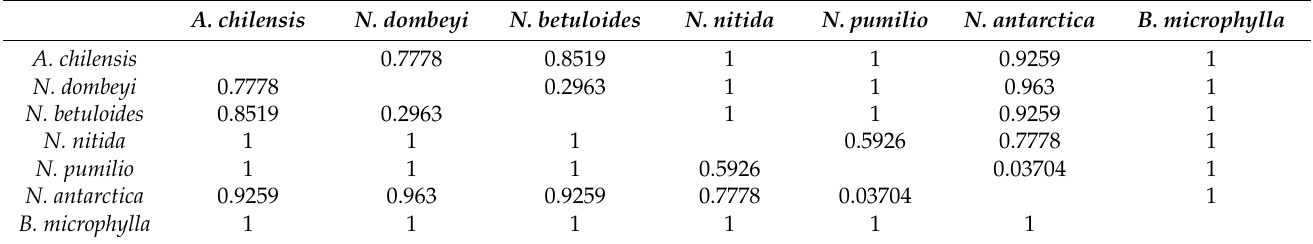
Table 1. Analysis of similarity (ANOSIM), R values.